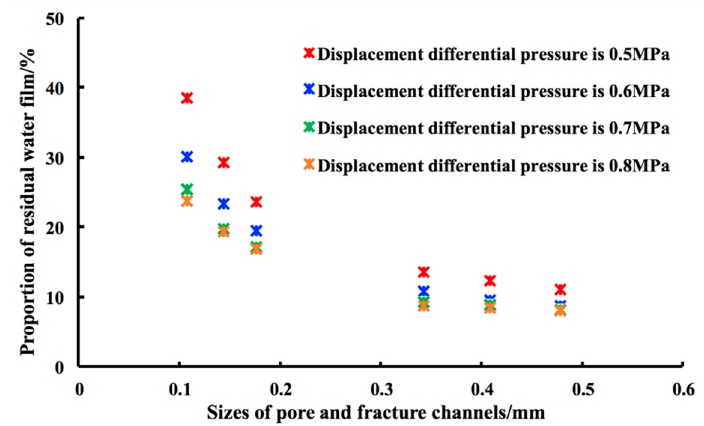
Figure 16. Proportion of residual water film in different size channels based on the ImageJ gray analysis method.